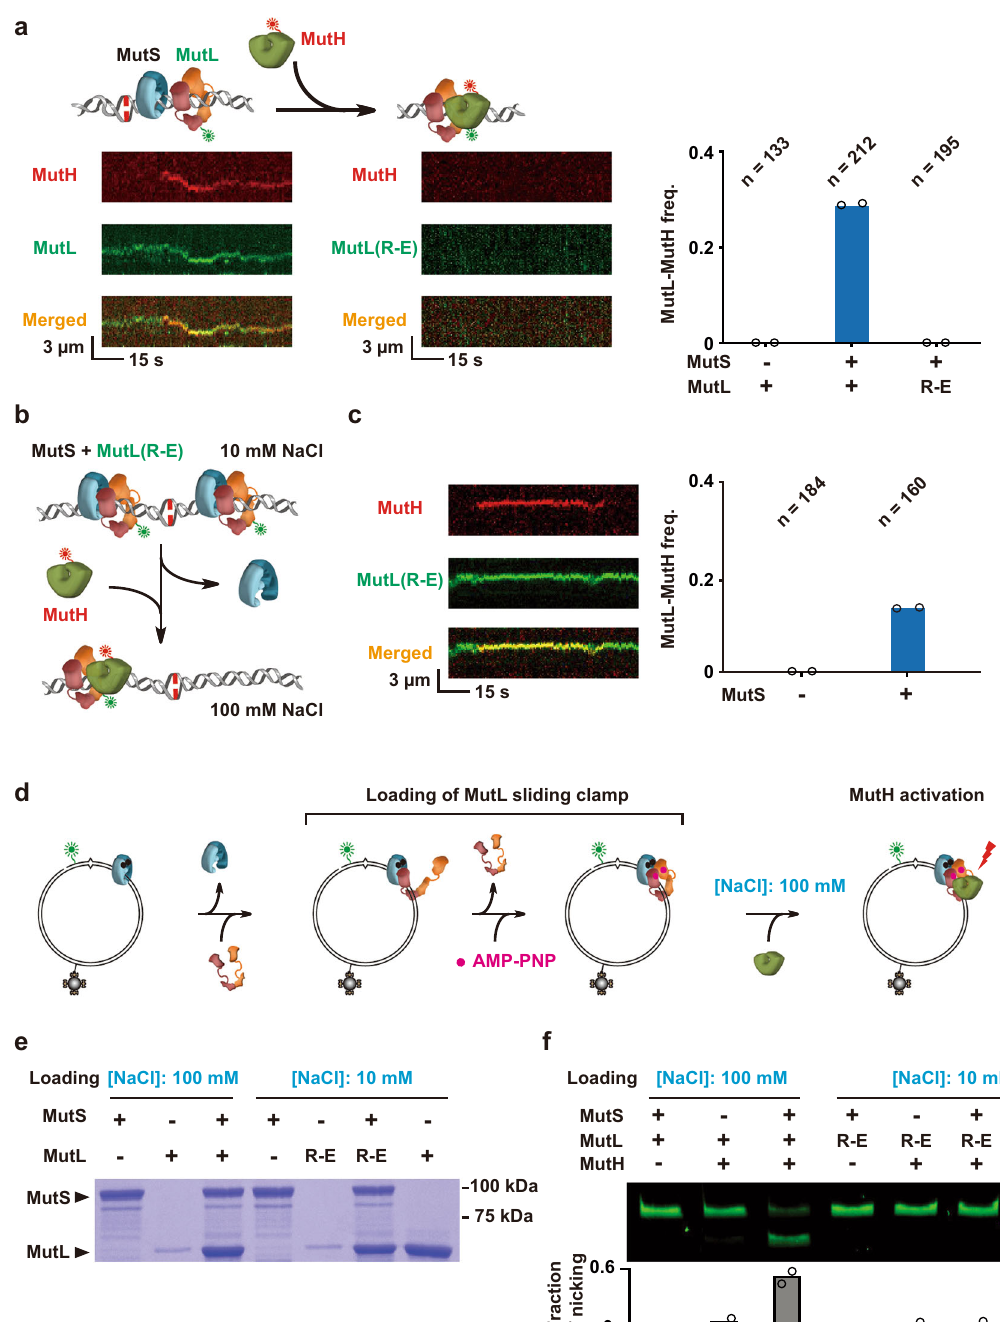
Fig. 6 | The MutL NTD positively charged cleft does not affect MutL-MutH binding but does enhance the MutL-MutH complex search and incision of hemimethylatedGATCsites.a Left: Illustration and representative kymographs showing a Cy3-MutL sliding clamp color-coded as described in Fig. 2b inter- acting with a Cy5-MutH endonuclease (green), while no interaction between Cy3-MutL(R-E) and Cy5-MutH was observed under physiological ionic condi- tions (~120mM). Right: The frequency of MutL-MutH complex formation under physiological ionic conditions (~120mM; n = total number of DNA molecules examined). b Illustration of the loading sequence for Cy3-MutL(R-E) sliding clamps onto the mismatched DNA followed by the addition of Cy5-MutH. MutS, Cy3-MutL(R-E) and Cy5-MutH color-coded as described in Figs. 2b, 6a. c Left: Representative kymograph of Cy3-MutL(R-E)/Cy5-MutH complex on a mis- matched DNA; Right: the frequency of Cy3-MutL(R-E)/Cy5-MutH complexes in the absence/presence of MutS (n = total number of DNA molecules examined).